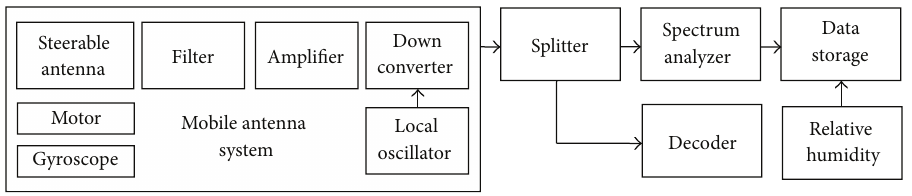
Figure 3: Measurement setup.